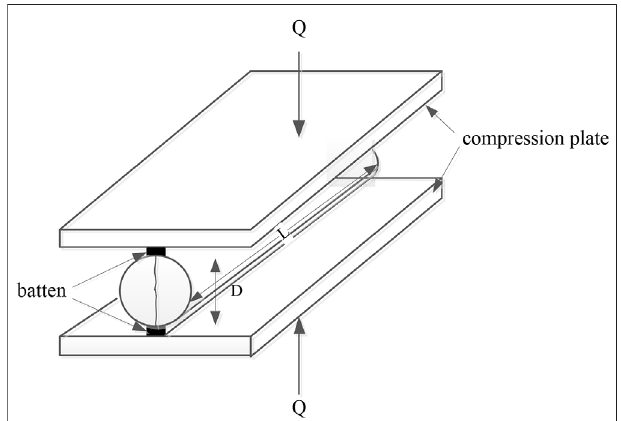
FIGURE 2 | Radial-splitting test